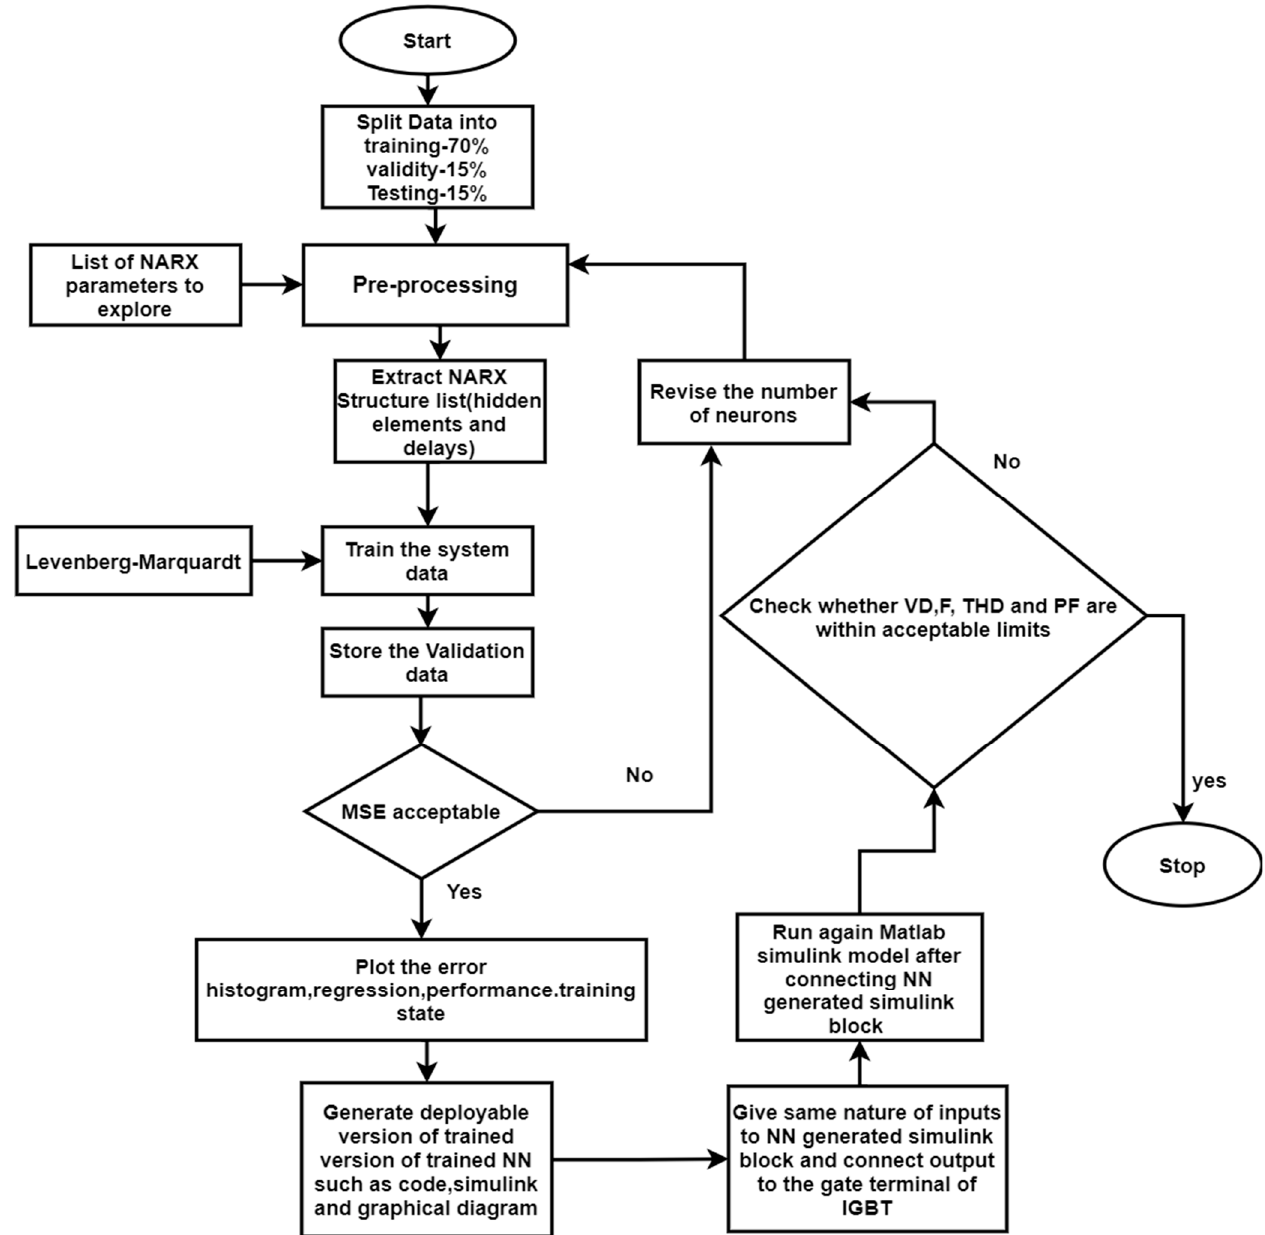
Figure 6. Flow chart showing Employment of NARX algorithm.